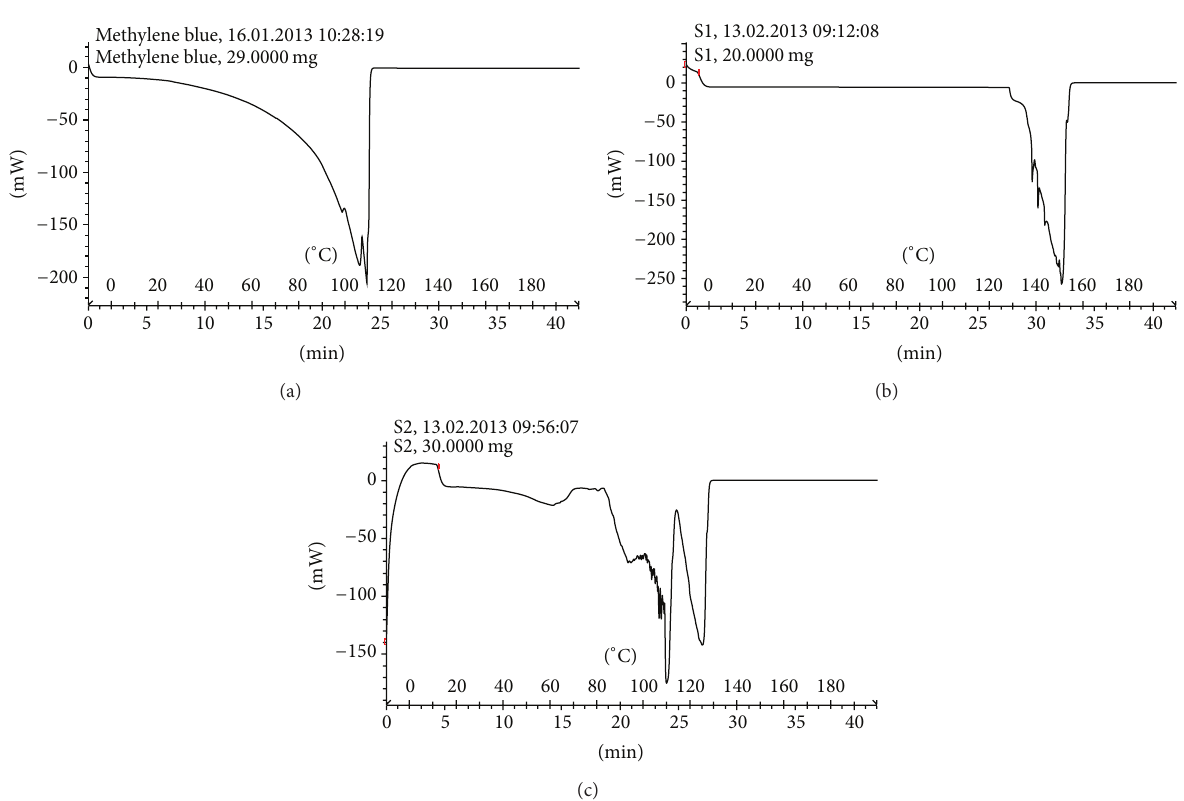
Figure 6: (a) Differential Scanning Calorimetry spectra of methylene blue (b) Archaeosomes without methylene blue and (c) Methylene blue containing